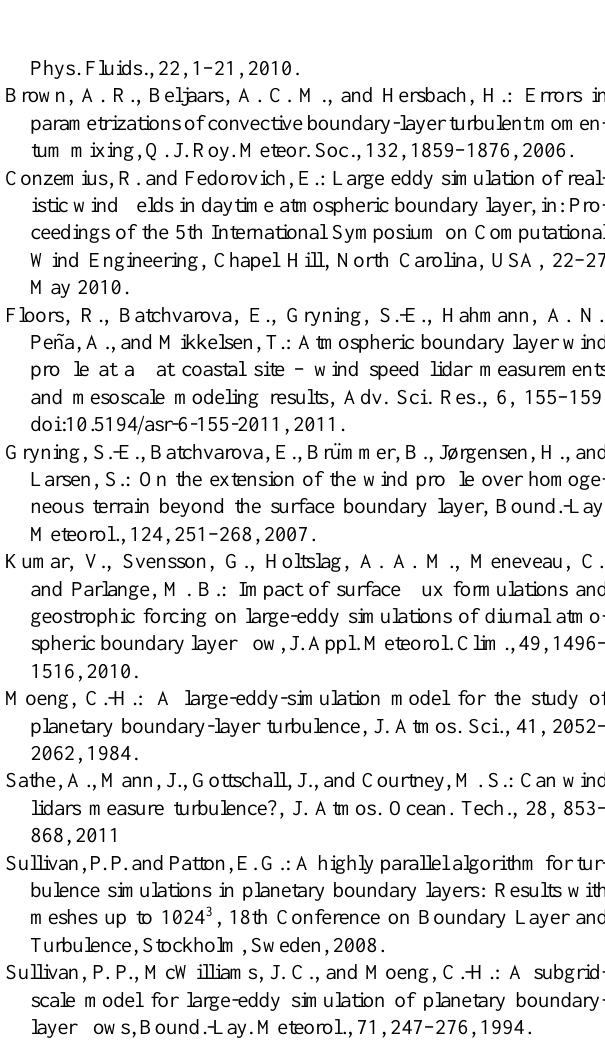
Figure 4. Profiles of σ w from simulation C (a) and D (b)